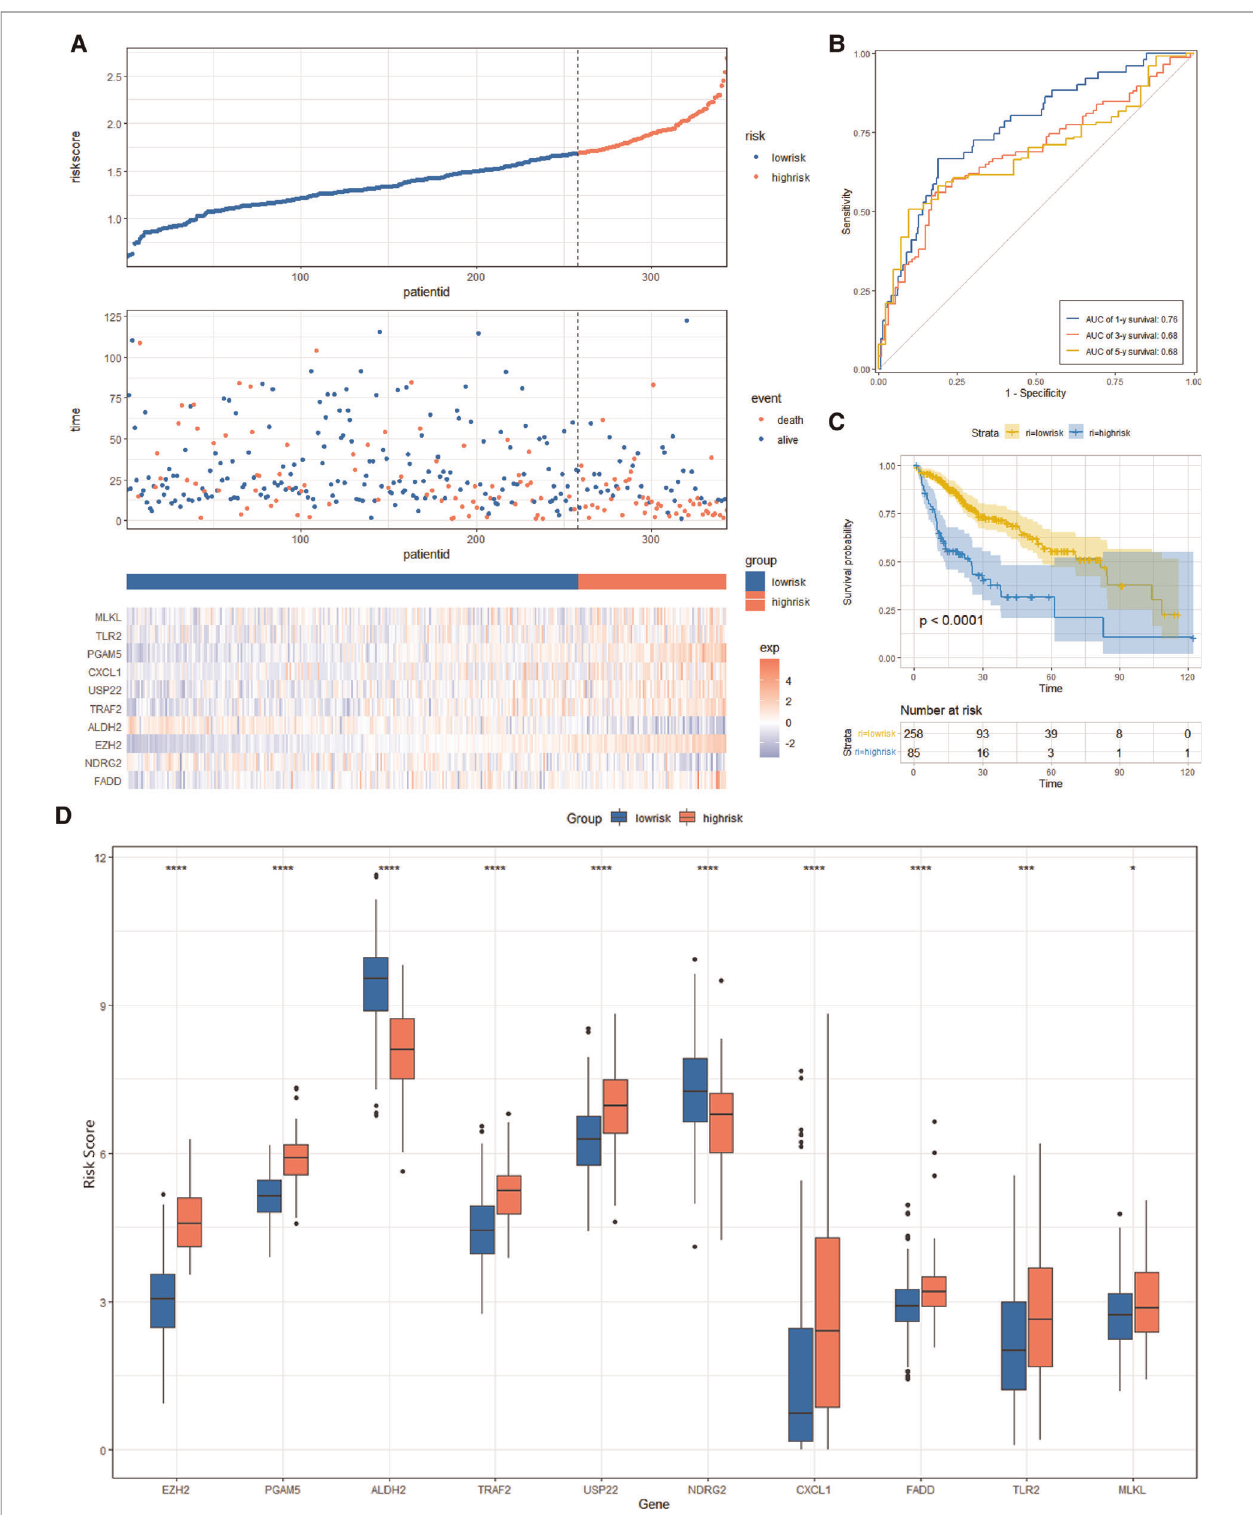
FIGURE 8 | Risk score analysis, prognostic performance, and survival analysis of the Risk Score Signature in the TCGA cohort. ( A ) Risk score and survival time distribution of patients and gene expression of necroptosis-related genes in the Risk Score Signature. ( B and C ) Overall survival curve and ROC curve of the Signature. ( D ) Key molecules expressed in the low- and high-risk